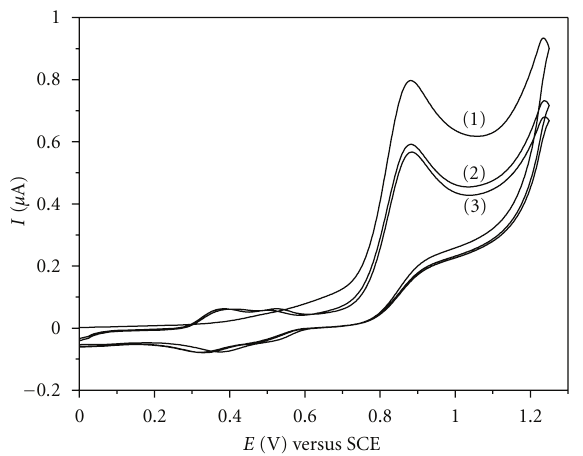
Figure 2: Cyclic voltammograms of 0.03mM ASA. E ff ect of scan rate: (1) 0.005Vs − 1 , (2) 0.01Vs − 1 , (3) 0.015Vs − 1 , (4) 0.02Vs − 1 , (5) 0.025Vs − 1 , (6) 0.03Vs − 1 ; supporting electrolyte: 0.1M Na 2 SO 4